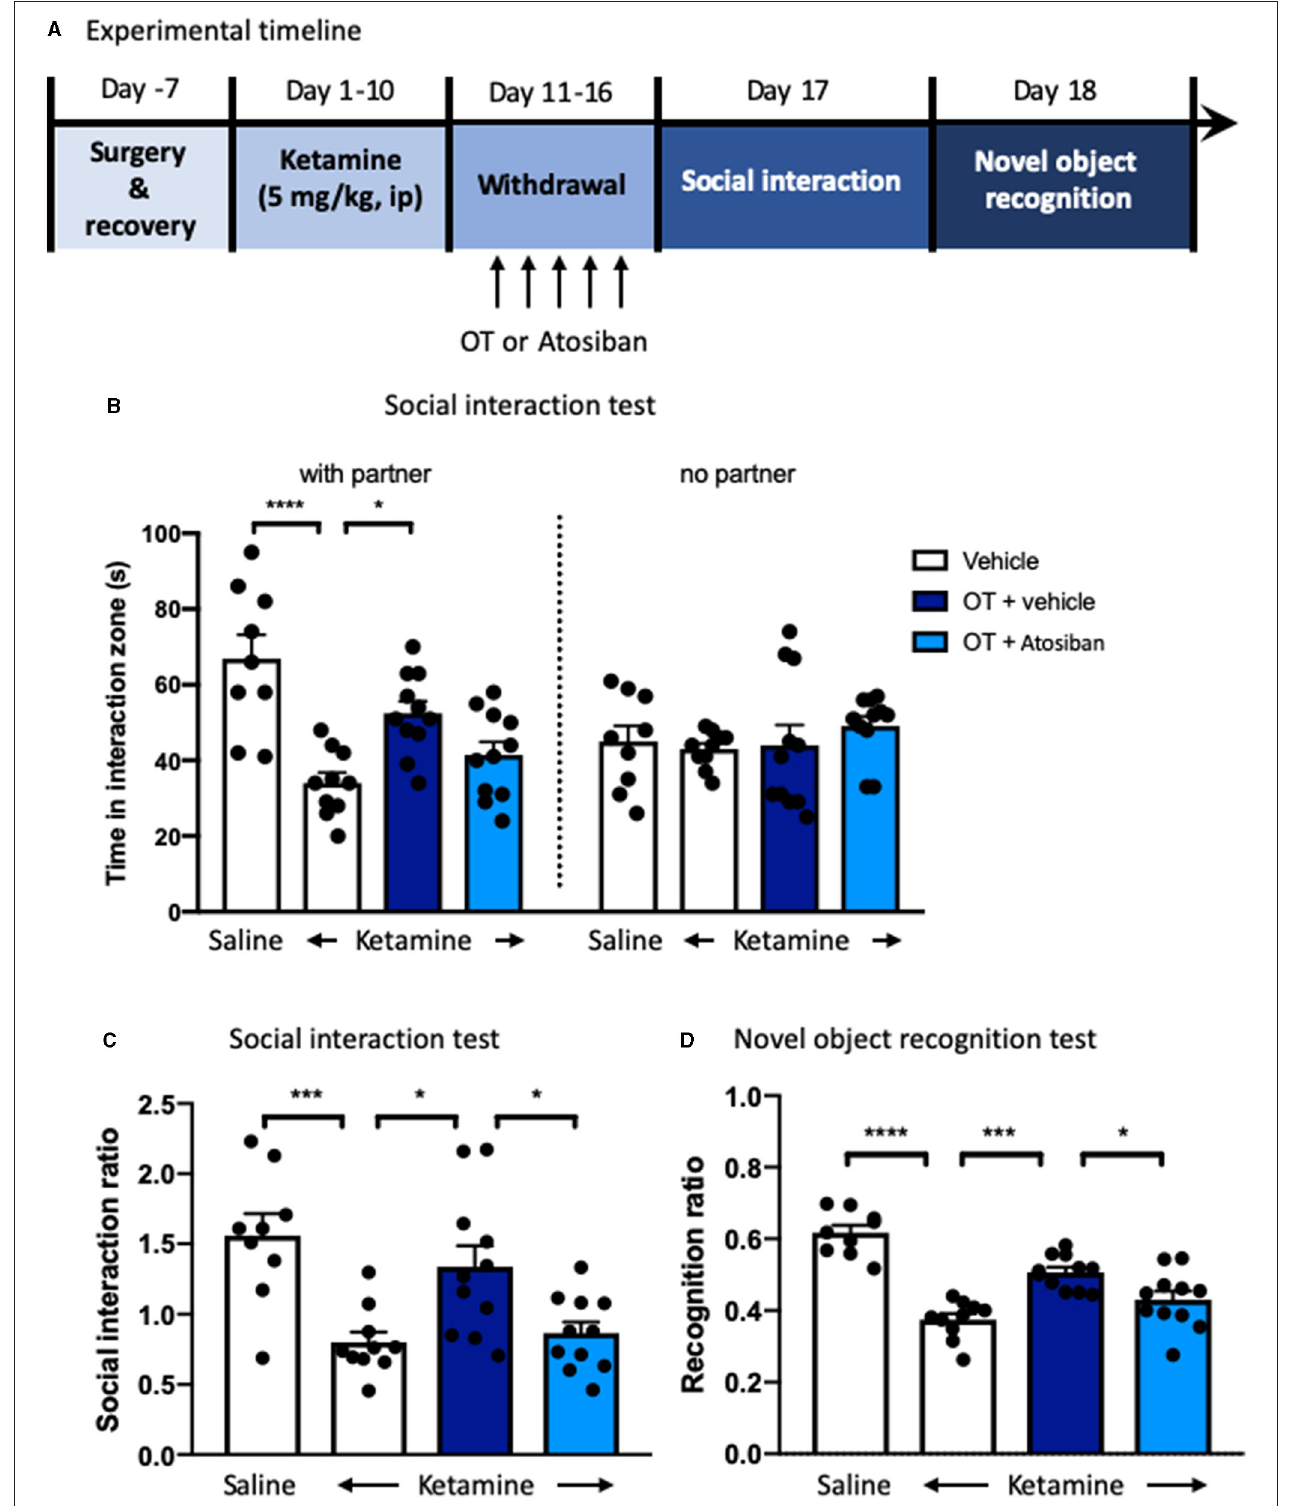
FIGURE 6 | Oxytocin receptor antagonist blocks the reversal effects of oxytocin on behavioral impairments in ketamine-treated mice. (A) Experimental timeline for ketamine treatment, oxytocin, or oxytocin receptor antagonist atosiban microinjection, and behavioral protocol. (B) The time spent in the social interaction zone, and (C) the social interaction ratio measured in the social interaction test. (D) The recognition ratio measured in the novel object recognition test. Data are presented as mean ± SEM * p < 0.05, *** p < 0.001, **** p < 0.0001, compared with saline, ketamine-vehicle, or ketamine-OT group. n = 9–11 per group. OT, oxytocin.